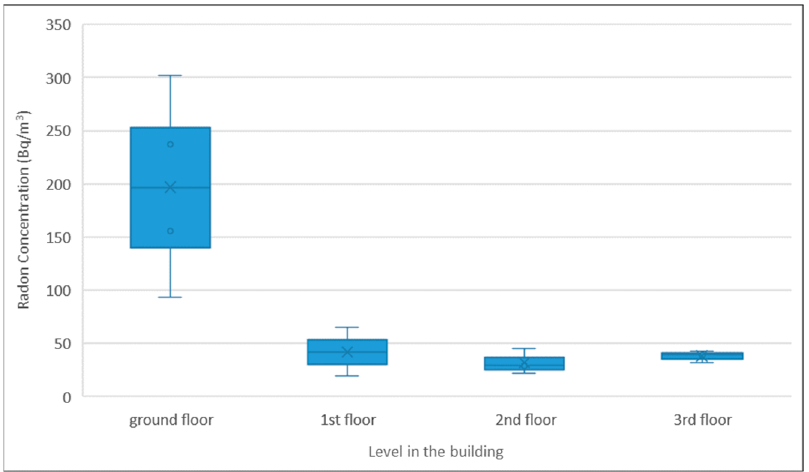
Figure 1. The distribution of annual indoor radon concentration according to floor level—school 1.